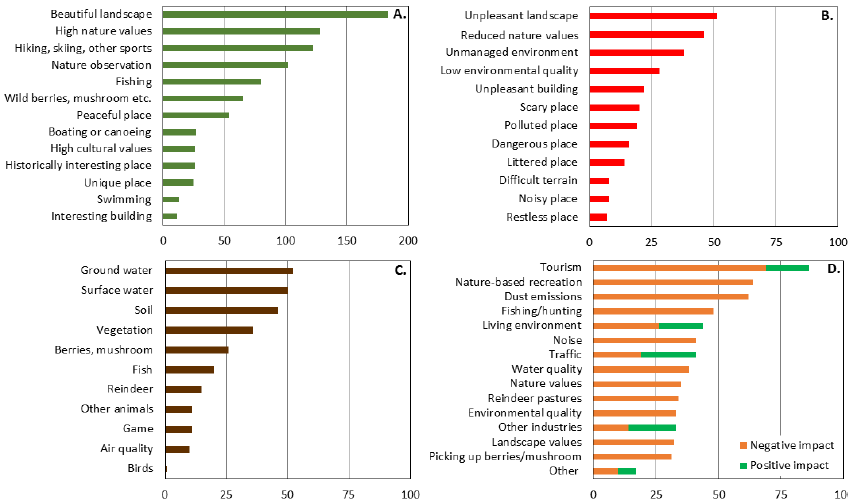
Figure 7. Total numbers of descriptions related to ( A ) pleasant places (positive experiences), ( B ) unpleasant places (negative experiences), ( C ) places where more knowledge is needed on the state of the environment, and ( D ) places were potential impacts of new mining activities would be experienced. One map marking can include multiple descriptions (e.g., a pleasant place can be a beautiful landscape with high nature value).